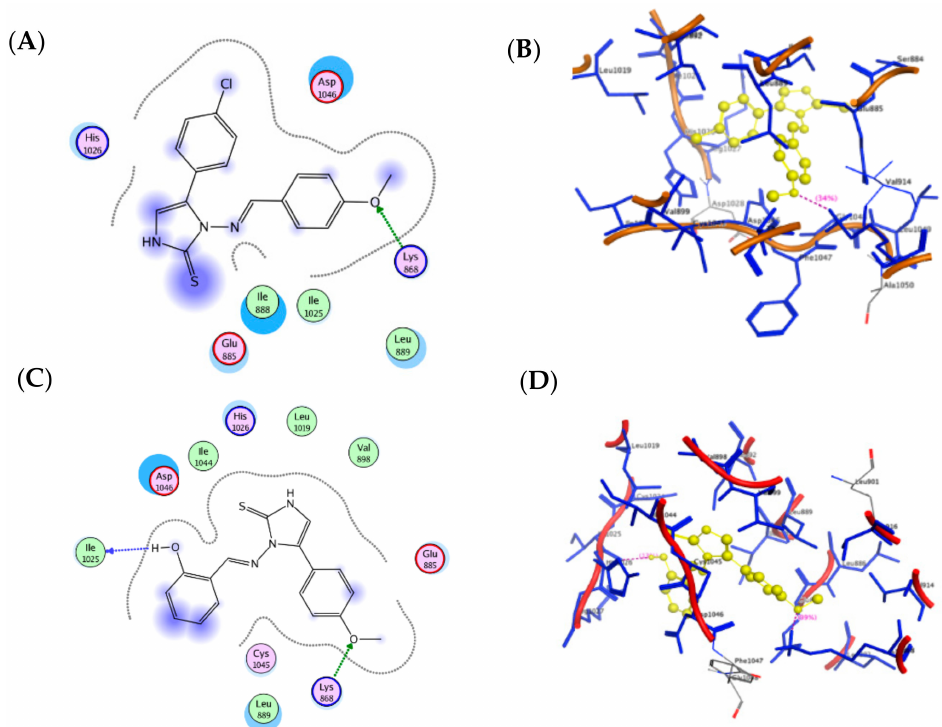
Figure 6. ( A ) 2D representation of compound 4d docking inside the active site of 3U6J. ( B ) 3D representation of compound 4d docking inside the active site of 3U6J. ( C ) 2D representation of compound 5 docking inside the active site of 3U6J. ( D ) 3D representation of compound 5 docking inside the active site of